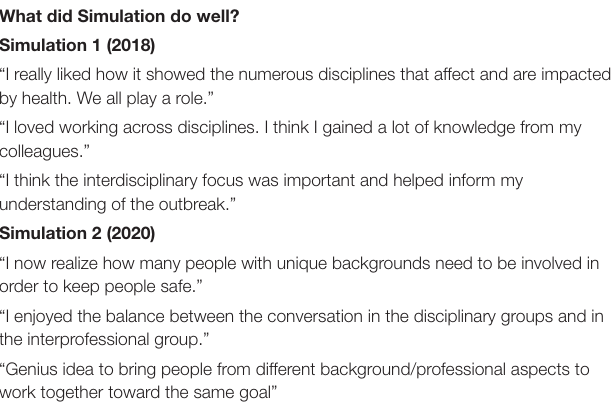
TABLE 4 | This table contains examples of comments made by students about the simulation. What did Simulation do